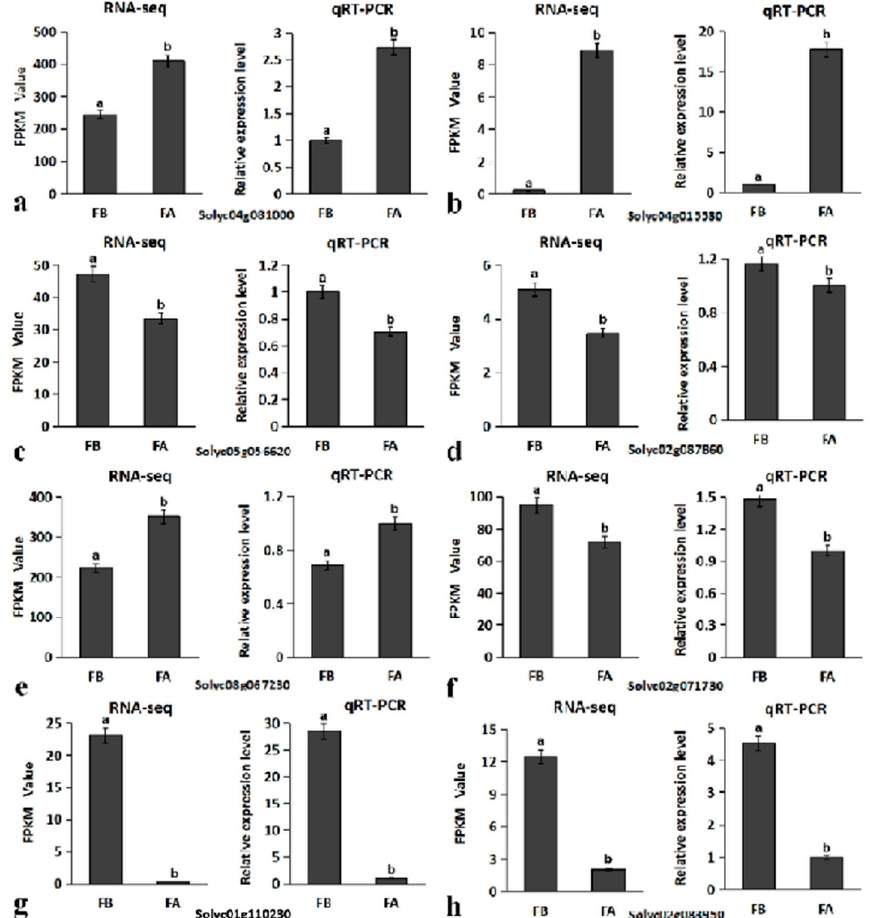
Figure 7. Comparison of RNA-seq and qRT-PCR expression results. FPKM values of eight DEGs were obtained by RNA-seq, and relative mRNA levels were obtained by qRT-PCR. Three technical replicates were performed for each biological replicate of each sample. Error bars indicate the standard deviation. p < 0.05 indicates a significant difference: a is significantly higher than b, and a significant difference between the same letters. Note: FB: flower bud; FA: full-bloom stage. Different letters indicate significant differences at the p < 0.05 level. Subfigures ( a – h ) correspond to qRT-PCR validation of the respective RNA-Seq data of the eight genes